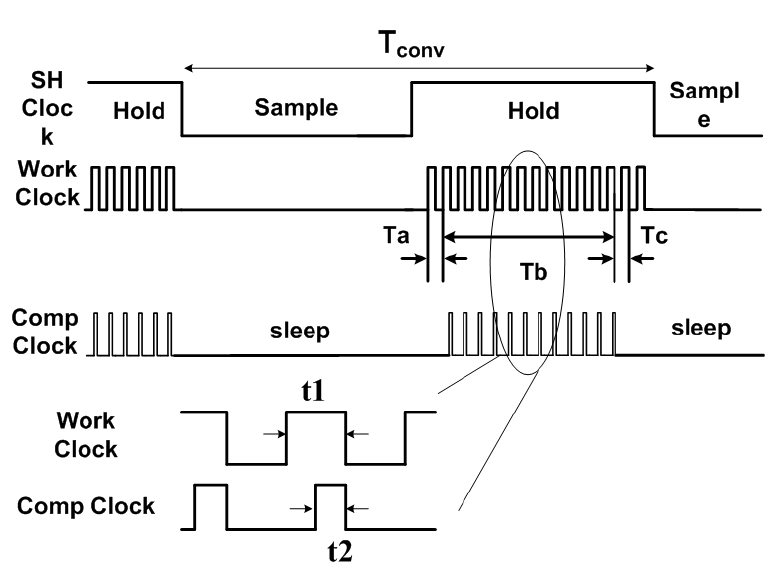
Figure 10. Operation waveforms of the SAR ADC.